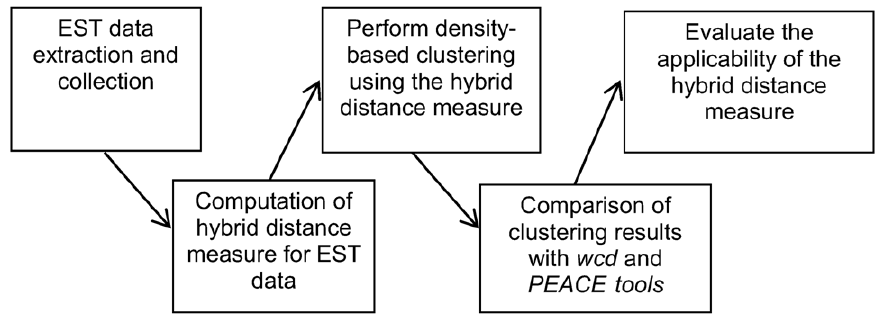
Figure 1. An overview of our experimental study on the proposed hybrid distance measure.